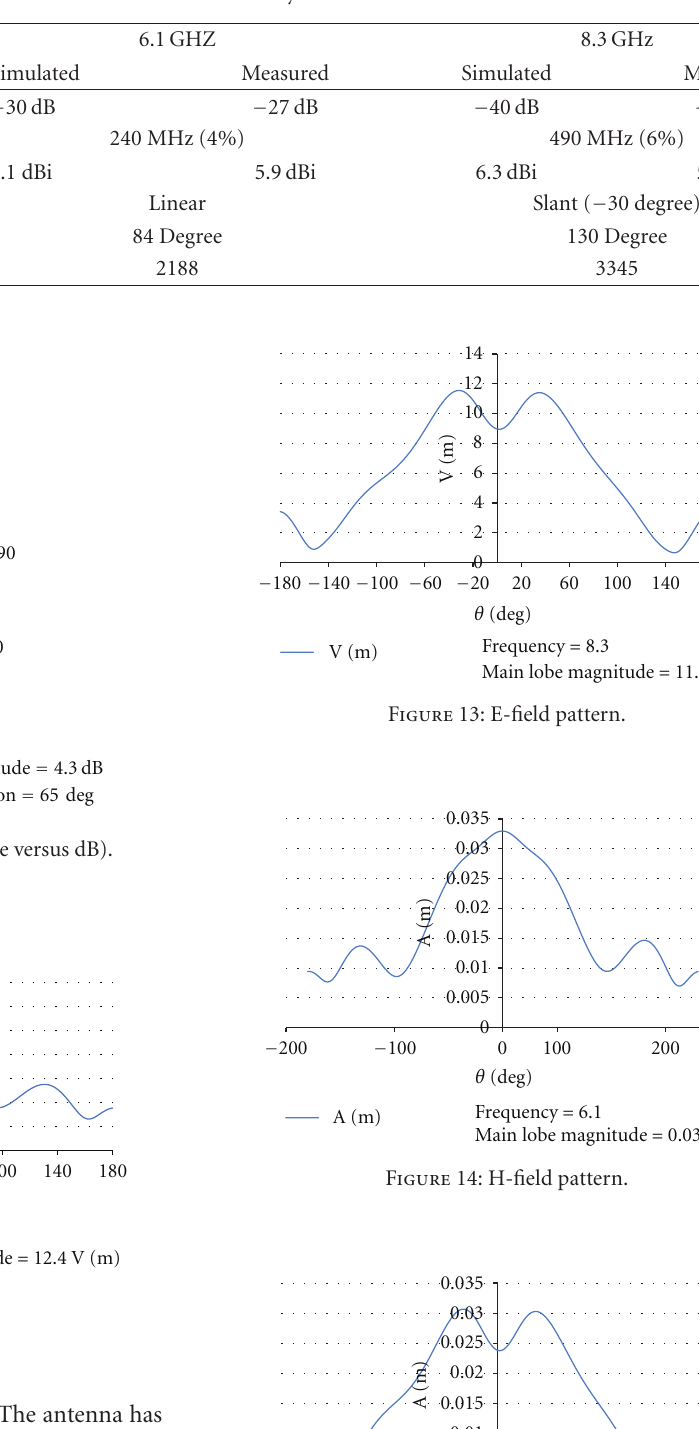
Table 1: Result summary.